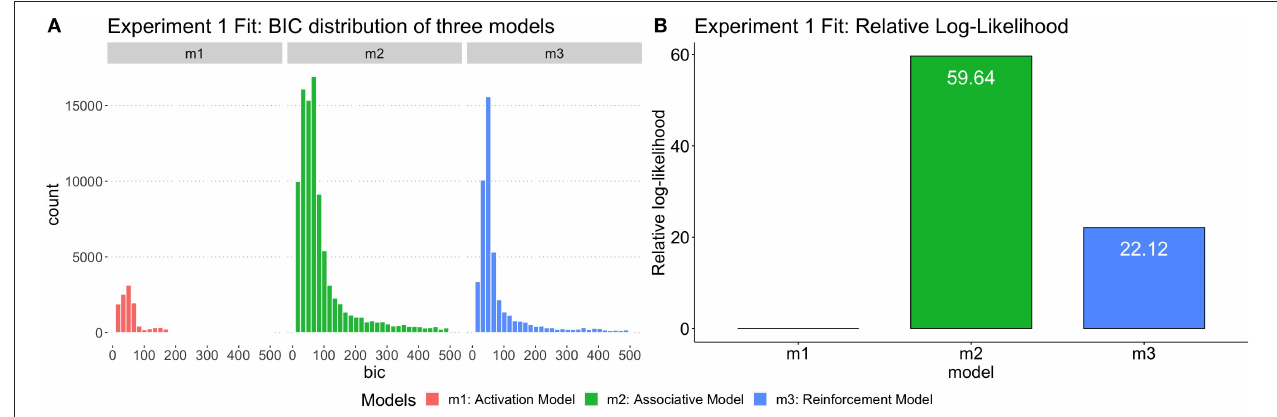
FIGURE 4 | (A) The distribution of BIC for three models fit by Experiment 1. (B) The relative log-likelihood of three models fit by Experiment 1 data. The relative-likelihood is the ratio of the group-level likelihood to the minimum log-likelihood of three models. Consistent with statistical analysis, one subject was excluded from simulation data analysis as well.